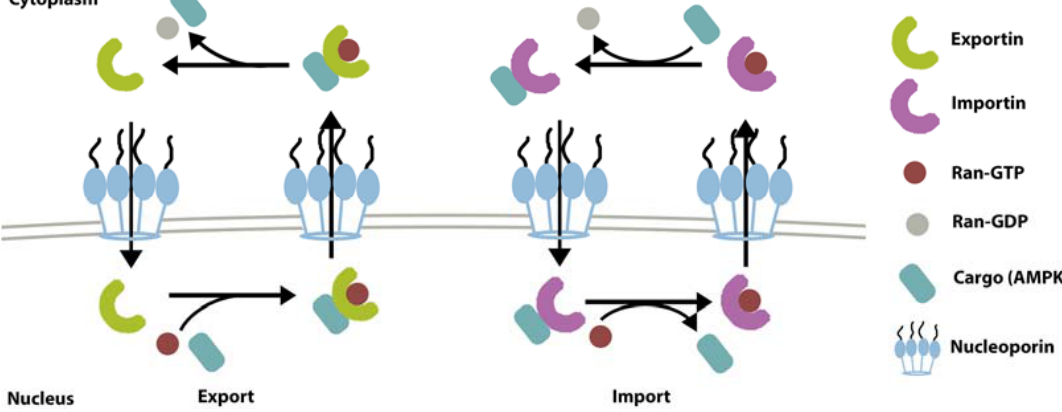
Figure 2. Mechanism of nuclear export and import with exportin and importin